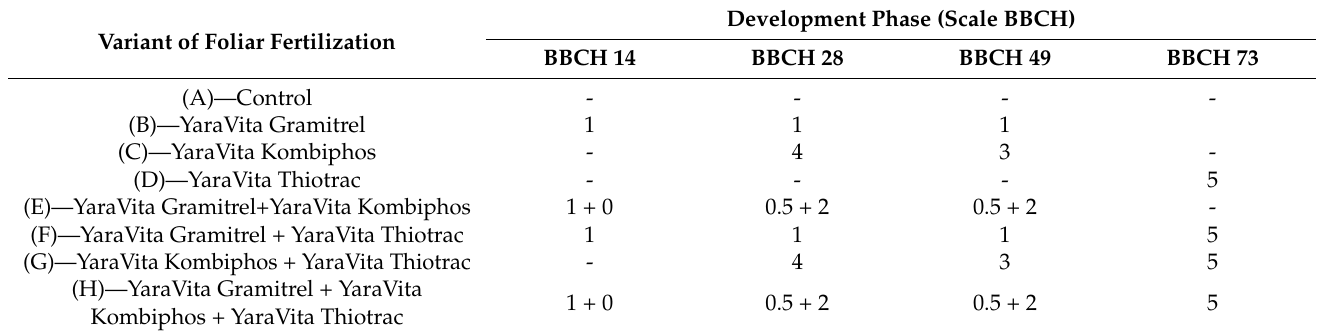
Table 1. Scheme of diversified fertilization of winter wheat (L·ha −1 ). Variant of Foliar Fertilization